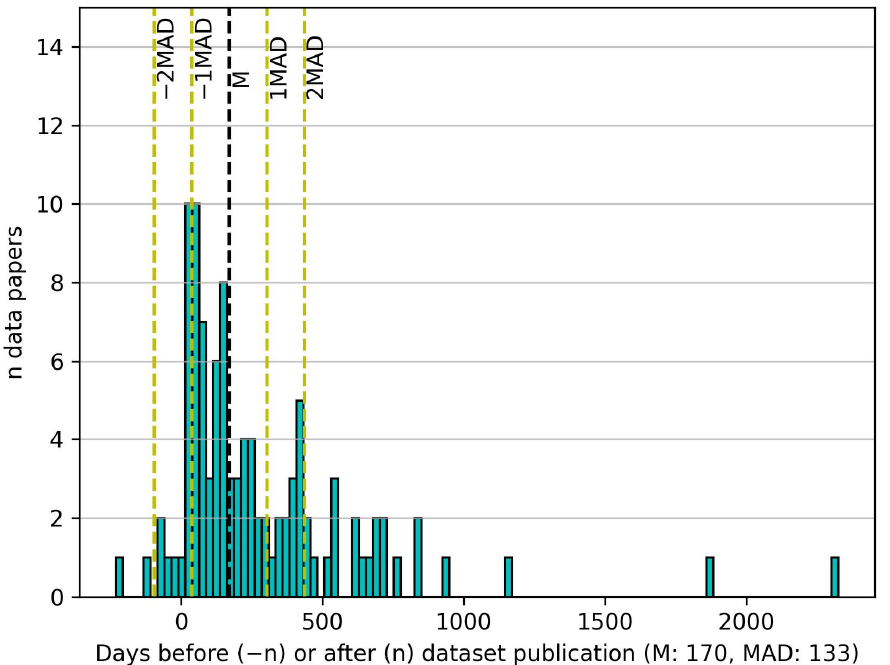
Figure 5. Number of days elapsed between the publication of a dataset in its public repository and the publication of the associated data paper by JOHD or RDJ. 0 on the x -axis is the date of publication of a dataset, so that one data point at 500 on the x -axis, for instance, indicates that one data paper was published 500 days after the publication of its associated dataset. M = median. MAD = median absolute deviation.